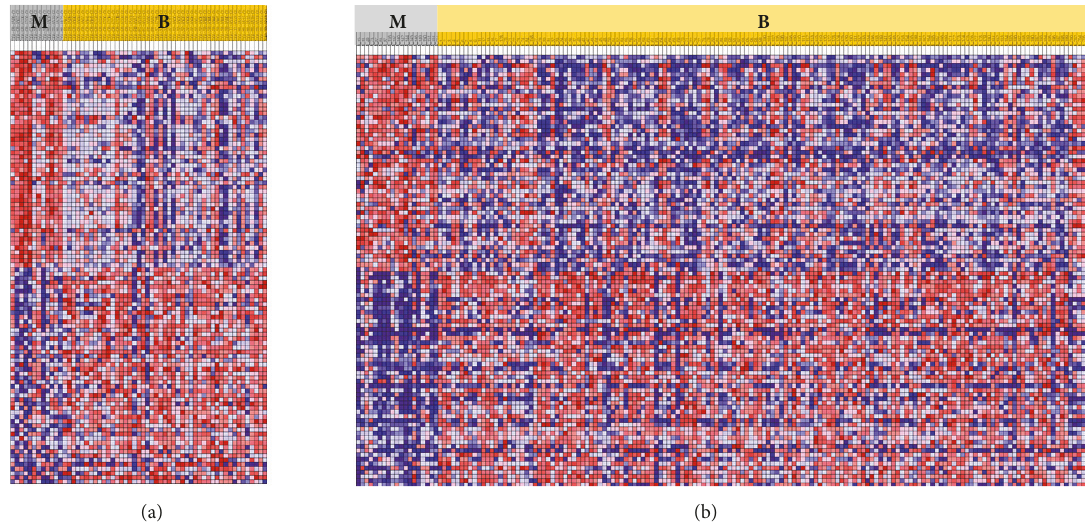
Figure 4: Gene Set Enrichment Analysis showing the heat map of top 50 features for each phenotype based on metastasis of PC/PG cases in